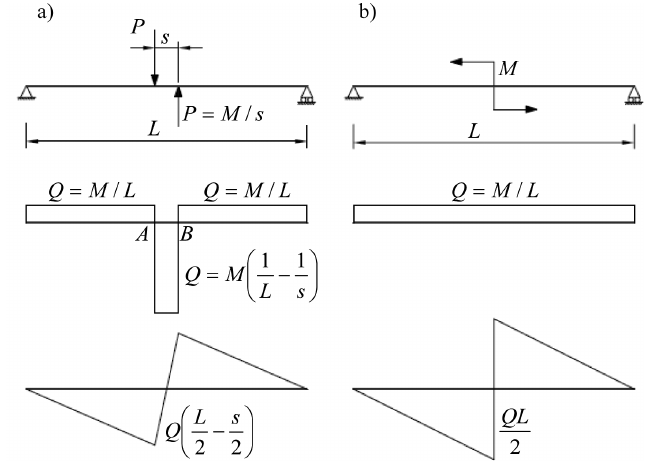
Fig. 4. Simply supported beam subjected to concentrated couples formed by, a) the vertical forces causing signi fi cant shear deformation, and b) the horizontal forces – no signi fi cant shear deformation [10].